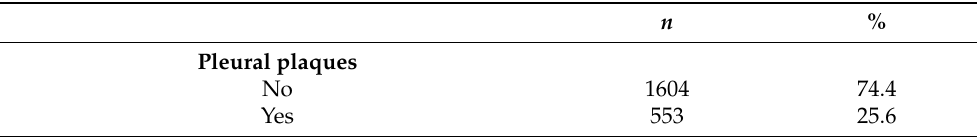
Figure 1. Study Flow-Chart. APEXS: Asbestos Post-Exposure Survey; ARDCO: Asbestos-Related Diseases Cohort; CT = computed tomography. Table 1. Frequency of pleural plaques, interstitial abnormalities and emphysema as detected at CT ( n =